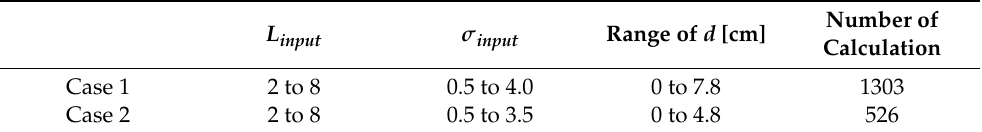
Table 2. Number of calculations and conditions used.